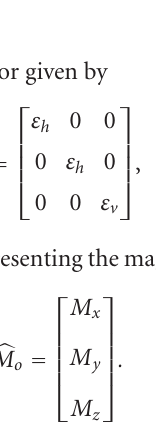
Figure 2: Basic structure of a triaxial induction tool. (a) The original model; (b) the equivalent model.